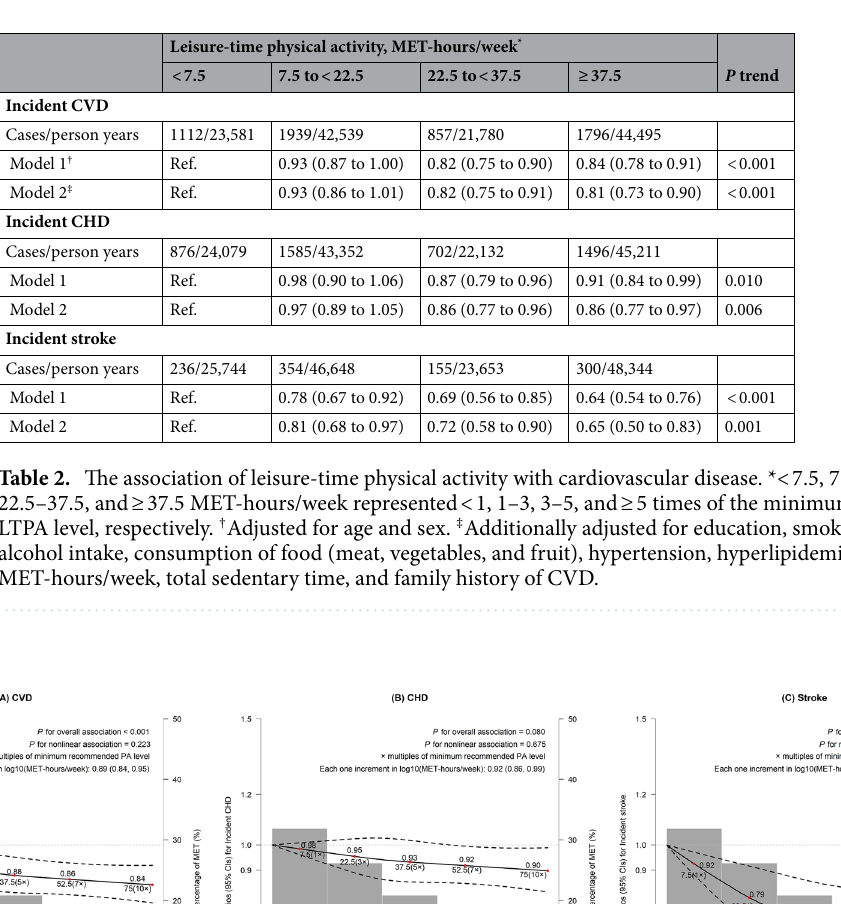
week; HR, 0.81 [95% CI 0.73 to 0.90]). The adjusted HRs (95% CIs) for CVD across categories of LTPA (7.5 to ≤ 22.5, 22.5 to ≤ 37.5, > 37.5 MET-hours/week) were 0.93 (0.86 to 1.01), 0.82 (0.75 to 0.91) and 0.81 (0.73 to 0.90), respectively ( P trend < 0.001). Similar associations were observed for both CHD ( P trend = 0.006) and stroke ( P trend = 0.001). Sensitivity analysis by extended adjustment or further exclusions did not appreciably alter the association (Supplementary Table S1 online). In stratified analysis, we found that the result was more obvious in male (HR 0.80 [95%CI 0.73 to 0.87]; P interaction = 0.02); and the cardiovascular benefits were consistent across age, education, smoking status, drinking status, BMI, hypertension, hyperlipidemia and diabetes. ( P interaction > 0.05; Supplementary Fig. S1 online). Cubic spline analysis showed that any level of LTPA was associated with significantly lower risks of CVD and stroke ( P CVD < 0.001, Fig. 1A; P stroke < 0.001, Fig. 1C). Each one increment in log 10 (MET-hours/week) was associated with 11%, 8%, and 20% lower risks of CVD (HR 0.89 [95% CI 0.84 to 0.95]), CHD (HR, 0.92 [95% CI 0.86 to 0.99]), and stroke (HR 0.80 [95% CI 0.69 to 0.92]), respectively (Fig. 1). Compared with no baseline LTPA, the most rapid decrease in CVD risk was seen before 3 times the WHO recommended minimum of PA. For total LTPA, the risks decreased by 8% for CVD (95% CI 2 to 14%) and 21% for stroke (95% CI 8 to 32%), respectively at 3 times the recommended minimum.